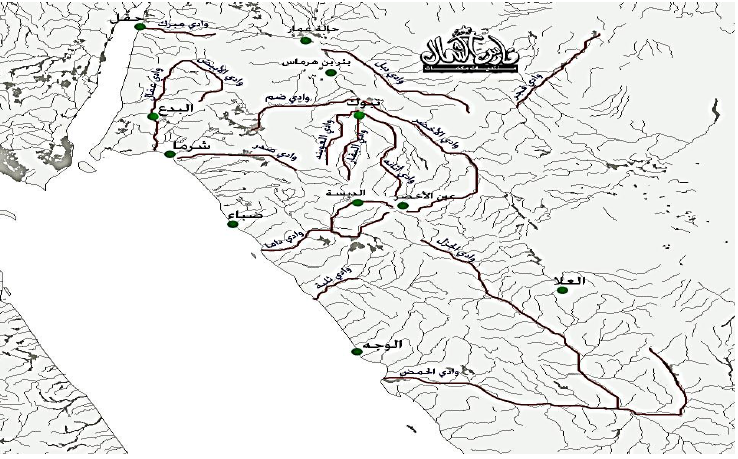
Fig. 1. Wadies layout in Tabuk area